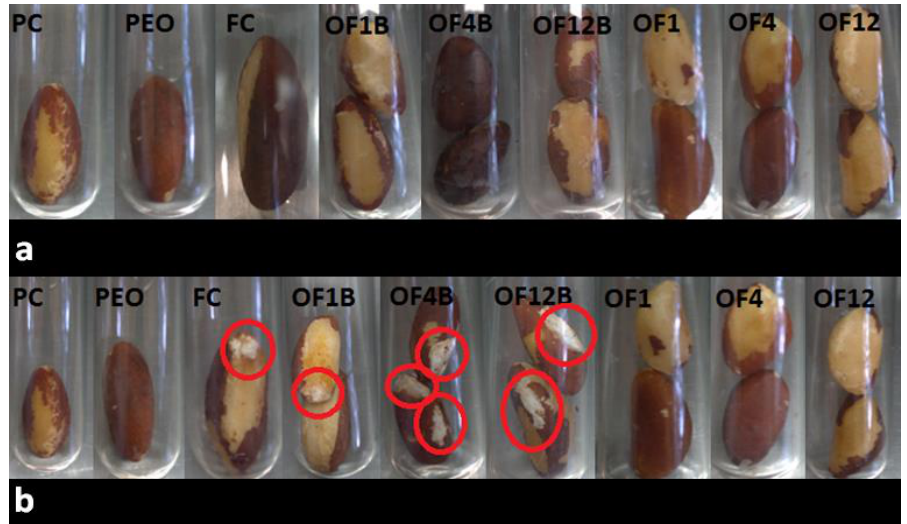
Figure 3. In situ antifungal activity test with Brazil nuts on the 1st day ( a ) and 10th day ( b ) after treatment. PC: positive control (Carbendazim at 250 µg mL −1 ); PEO: non-encapsulated Palmarosa essential oil (250 µg mL −1 ); FC: fungal control; OF1B: blank optimized formulation 1; OF4B: blank optimized formulation 4; OF12B: blank optimized formulation 12; OF1: optimized formulation 1; OF4: optimized formulation 4; OF12: optimized formulation 12.